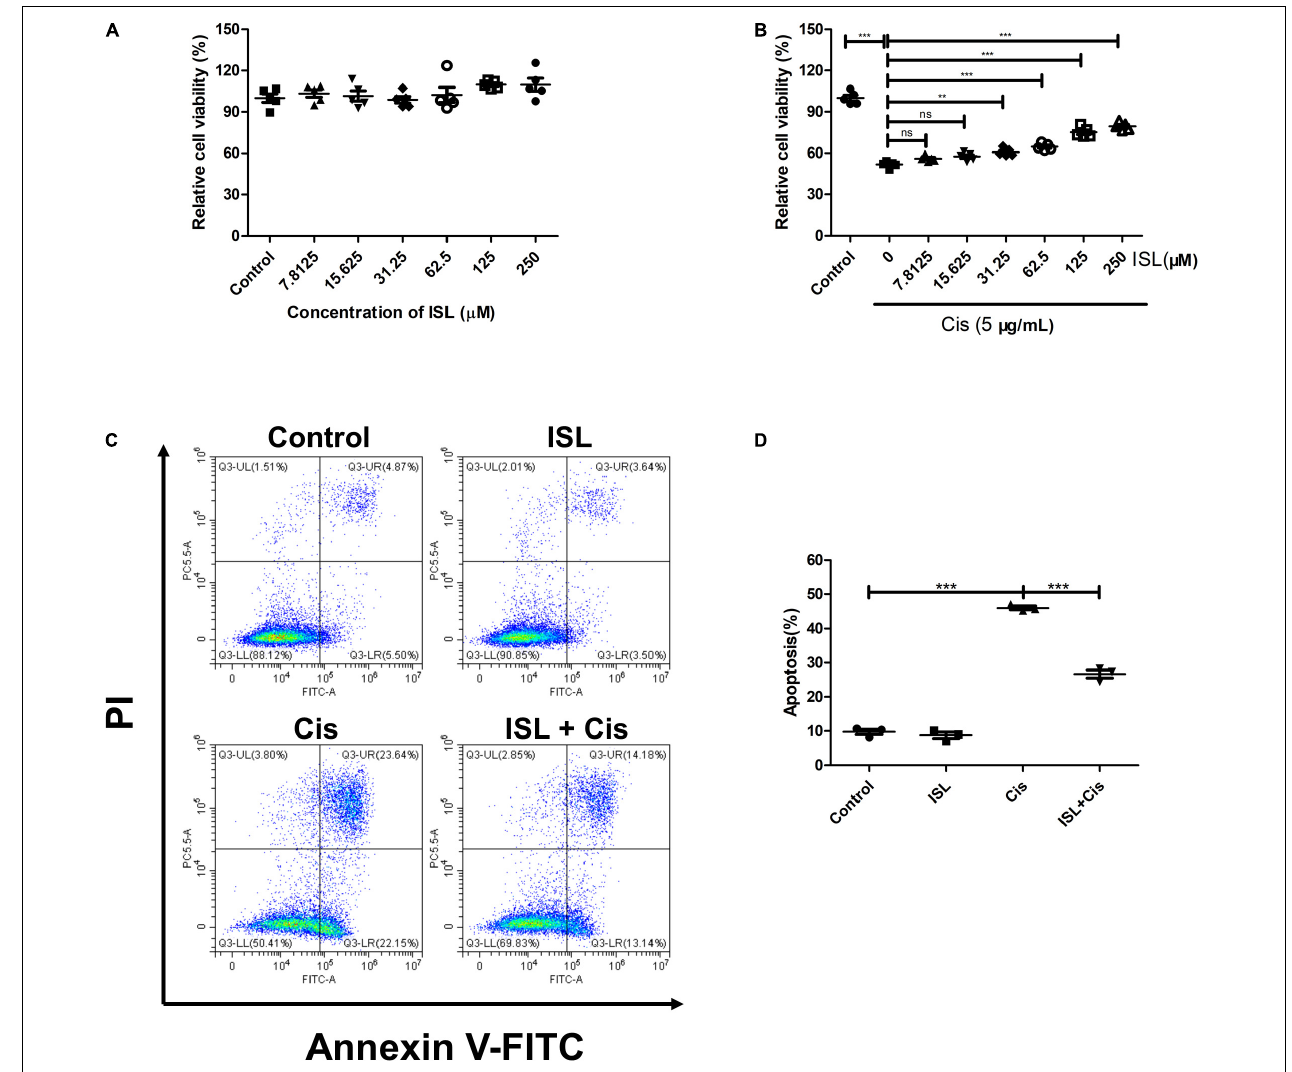
FIGURE 1 | ISL protected mPTCs against cisplatin-induced injury without side-effects. (A) mPTCs were administered different concentrations of ISL from 7.8125 to 250 µ M for 24 h. Cell viability was detected by a CCK-8 assay kit ( n = 5 per group). (B) mPTCs were pretreated with different concentrations of ISL for 6–8 h followed by stimulation with 5 µ g/mL cisplatin for 24 h. Cell viability was detected by a CCK-8 assay kit ( n = 5 per group). (C) Representative flow cytometry analysis of Annexin V and PI staining. mPTCs were pretreated with 62.5 µ M ISL for 6–8 h followed by stimulation with 5 µ g/mL cisplatin for 24 h. (D) Quantification of flow cytometry ( n = 3 per group). The data presented was expressed as mean ± SD of each group. ** p < 0.01, *** p < 0.001 (ANOVA with multiple comparisons). Cis, Cisplatin; ISL, isoliquiritin; CCK-8, Cell Counting Kit-8; PI, propidium iodide; SD, standard deviation; ANOVA, analysis of variance.